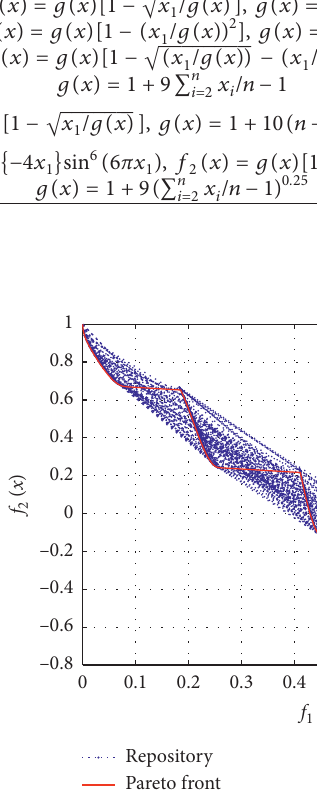
Figure 5: Pareto front produced by MOLFA for the ZDT3 test function.